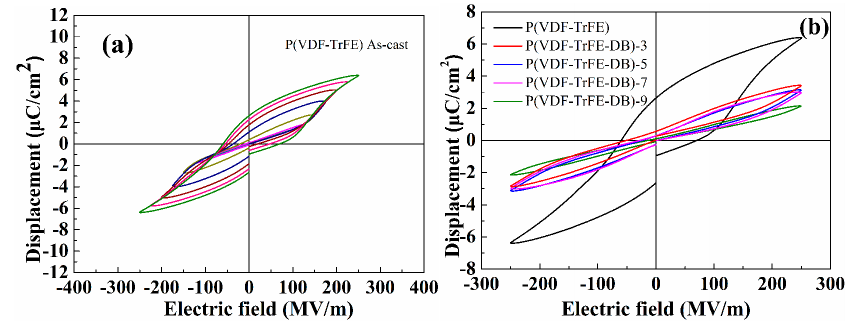
Figure 9. Bipolar D–E loops of P(VDF-TrFE) (20 mol % TrFE) film from solution cast at 50 °C ( a ) and